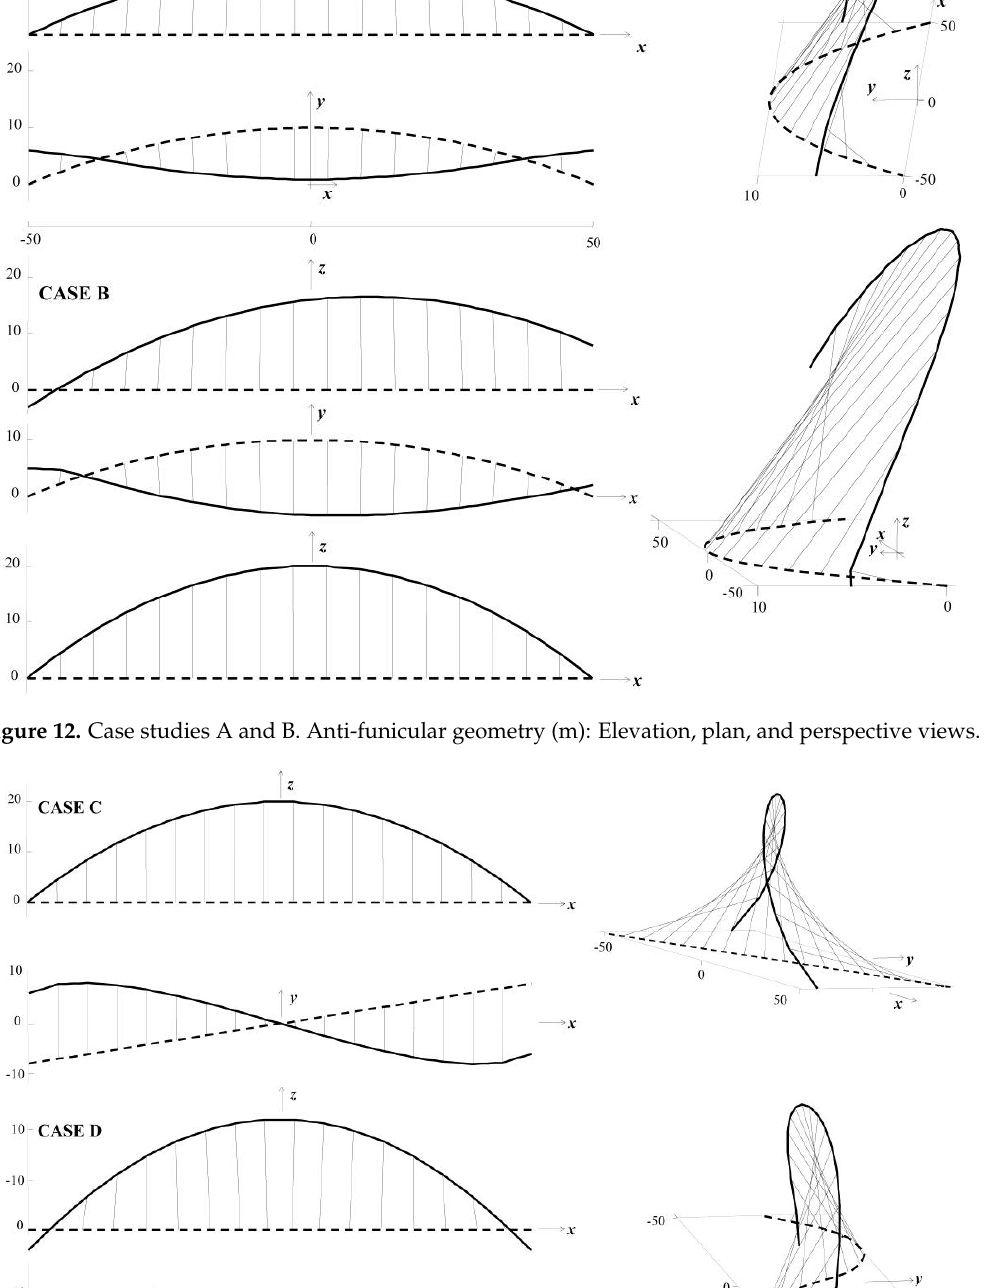
Figure 13. Case studies C and D. Anti-funicular geometry (m): Elevation, plan, and perspective views.